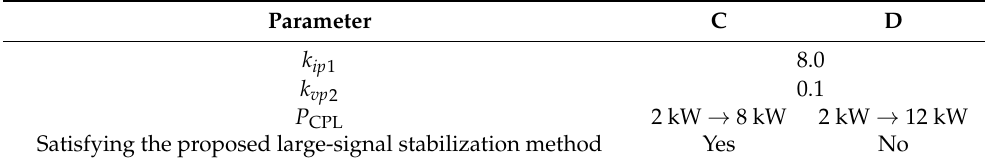
Table 3. Simulation parameters of Groups C and D.